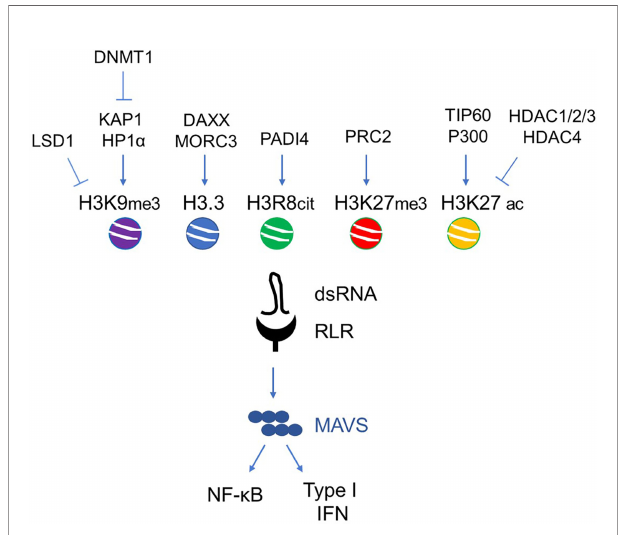
FIGURE 3 | Main histone epigenetic regulators involved in ERV de-repression during senescence and aging. Exemplary scheme of the agonistic/antagonistic epigenetic regulators acting on the chromatin remodeling of ERV